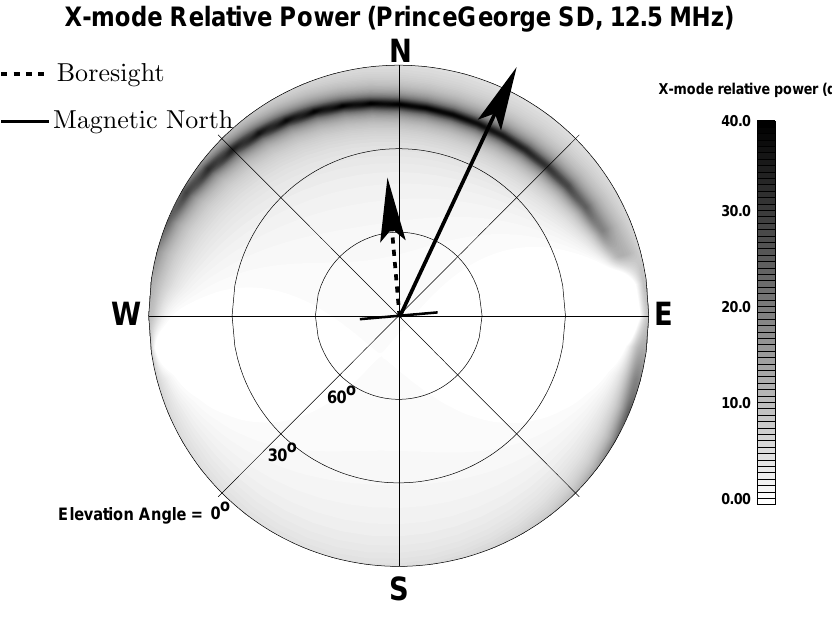
Fig. 4. Relative power delivered to the X-mode (Eq. 26) at 12.5MHz from the Prince George SuperDARN as a function of elevation and azimuth angles.